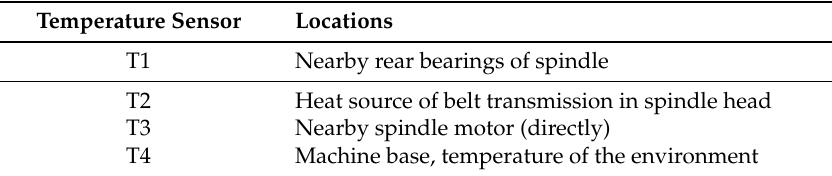
Table 1. Locations of the temperature sensors.